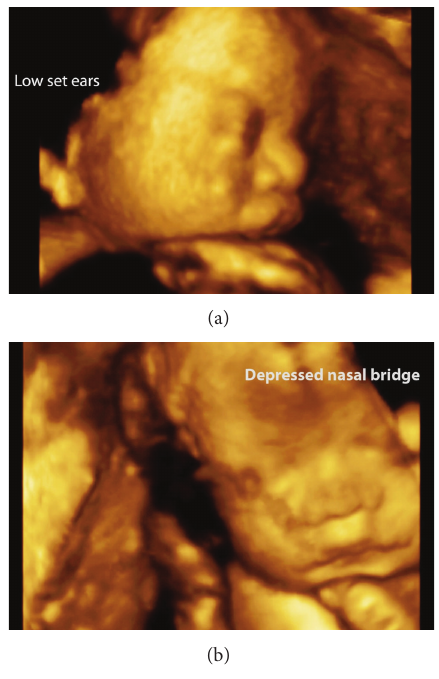
Figure 2: Three-dimensional ultrasound in the rendering mode findingsinafetuswithringchromosome15at19weeksofpregnancy. (a) Face fetus showing the low set ears. (b) Face fetus showing the depressed nasal